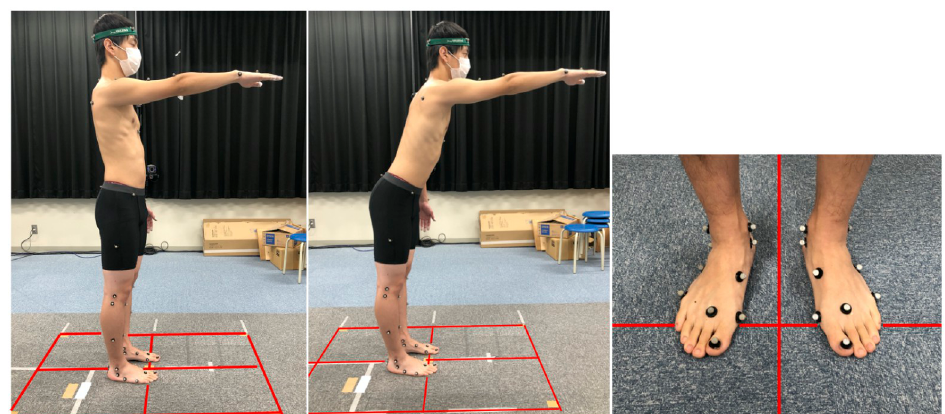
Fig 1. Measurement of limb position during the Functional Reach